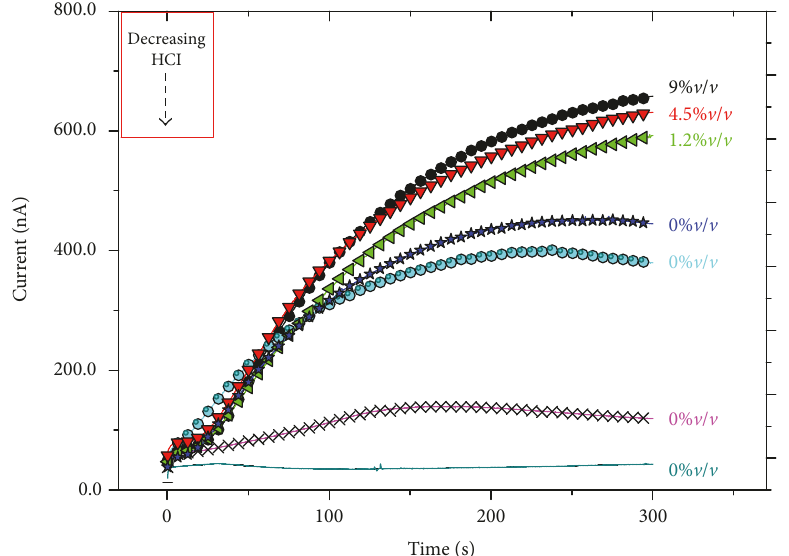
Figure 3: Memristor ’ s responses to the voltage stimulus reported in the inset of Figure 1 for a progressive lowering of chloride ion content in the polyelectrolyte: black circles represent the curve obtained with the polyelectrolyte solution at 9% v / v ; red triangles 4.5% v / v ; green triangles 1.2% v / v ; blue stars 0% v / v ; light blues 0% v / v (1 ° wash); pink line 0% v / v (2 ° wash); and dark green 0% v / v (3 °